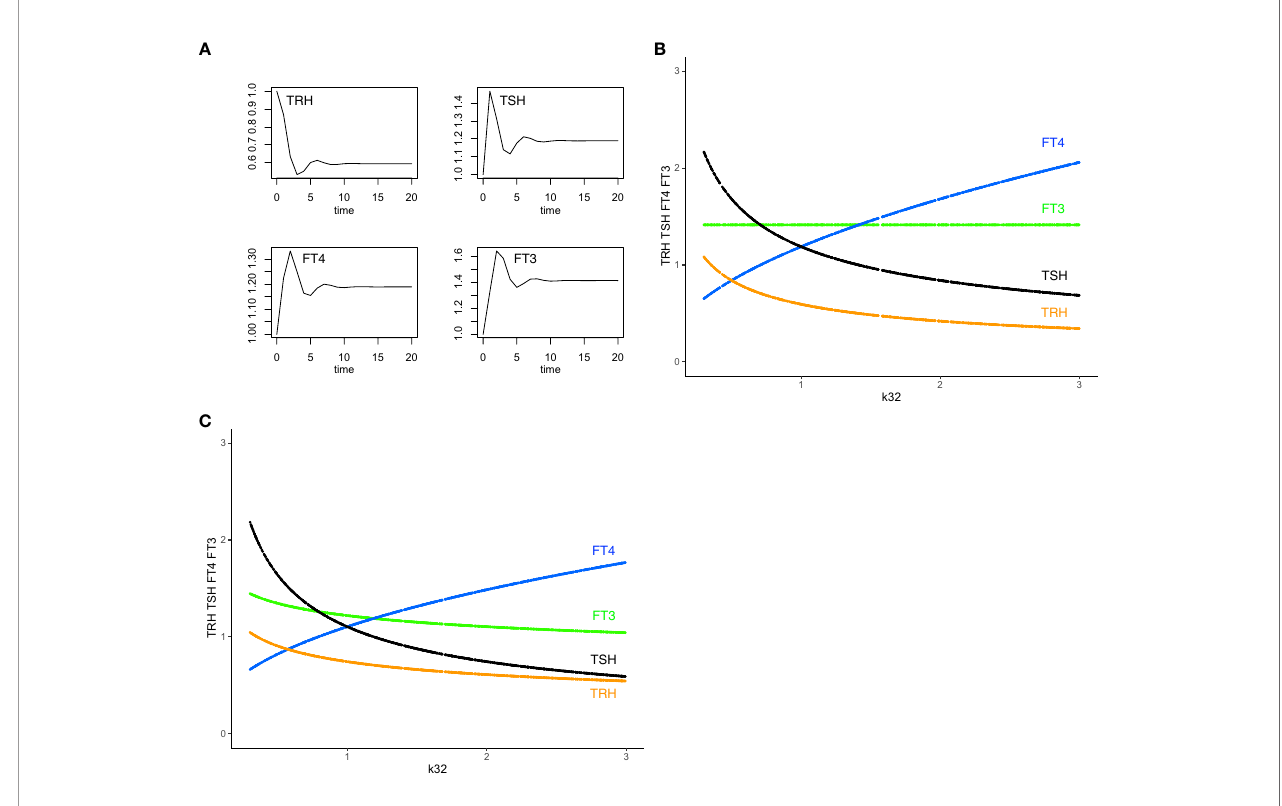
FIGURE 2 | The minimal HPT model and mechanisms to preserve FT3 homeostasis. (A) The time-dependent solution of system (sys. 1) approaches stable equilibrium for all four hormones. (B) In system (sys. 1), homeostasis of FT3 (green line) is preserved as k32 (FT4 production rate constant) varies. This mechanism renders FT3 concentration insensitive to variations in the amount of its precursor FT4 (blue curve) and the levels of TSH (black curve) and TRH (orange curve) ( “ perfect FT3 homeostasis ” ). (C) In contrast, the mechanisms of (sys.1 mod) do not preserve FT3 homeostasis. Color code of hormones: TRH orange, TSH black, FT4 blue, FT3